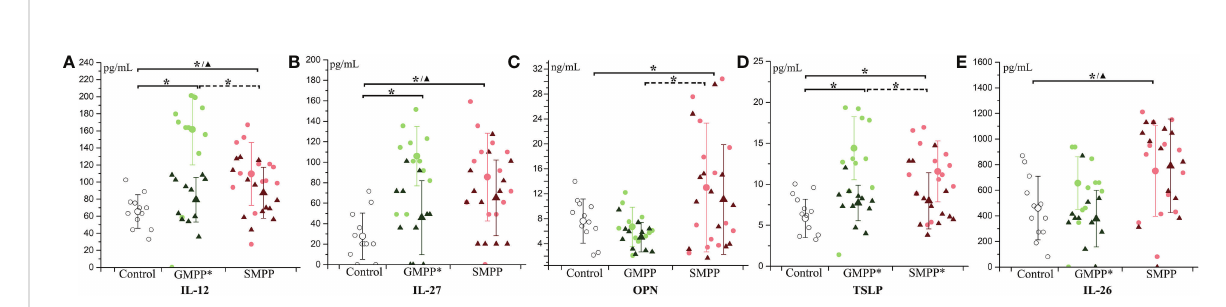
FIGURE 2 The level of T cell-related cytokines during MPP: (A) IL-12; (B) IL-27; (C) OPN; (D) TSLP; (E) IL-26. The healthy group (Control) is indicated with hollow circle; MPP groups are indicated with light circle (acute phase) and dark triangle (convalescent phase) of different colors (green: GMPP; red: SMPP). Mean values and standard deviations (STD) were represented with larger symbols. Signi fi cant differences (p < 0.05) were indicated with solid line (to the control group) or dotted line (between MPP groups) marked with * represents the acute phase, ▲ represents the convalescent phase. Signi fi cant differences (p < 0.05) between acute phase and convalescent phase were marked with * on group